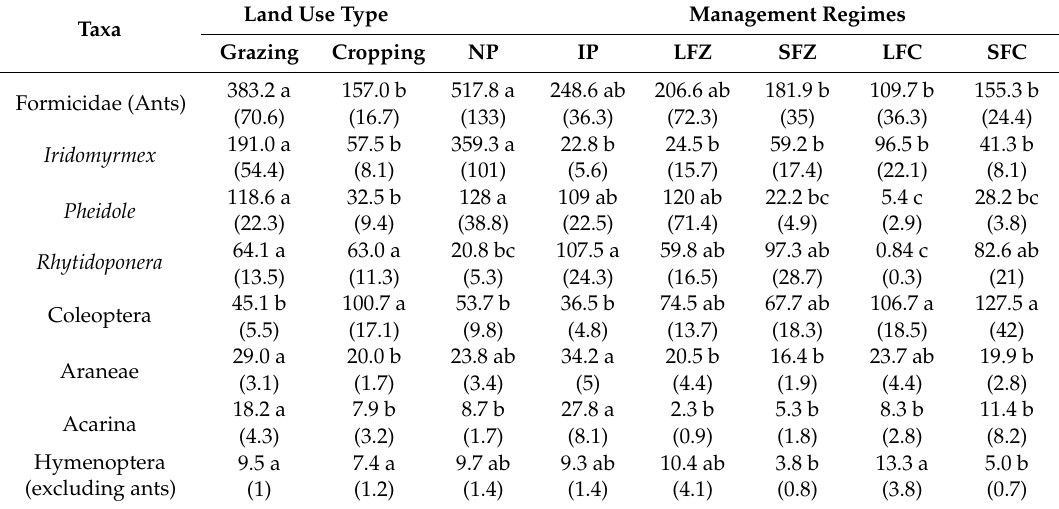
Table 4. Mean abundance (standard error of mean) of invertebrate taxa recorded in pitfall traps (total number per field), across land use and agricultural management regimes. Each data point was the total abundance of 20 pitfall traps per field. Each field was sampled eight times (once each season over two years), the number of replicates for each land use type or management regime is dependent on groupings. For each taxa, where there were significant di ff erences ( p < 0.05). Within rows and category, means followed by di ff erent letters were significantly di ff erent at p < 0.05. Comparison of mean (Tukey’s HSD) were completed within the category of land use type, and agricultural management